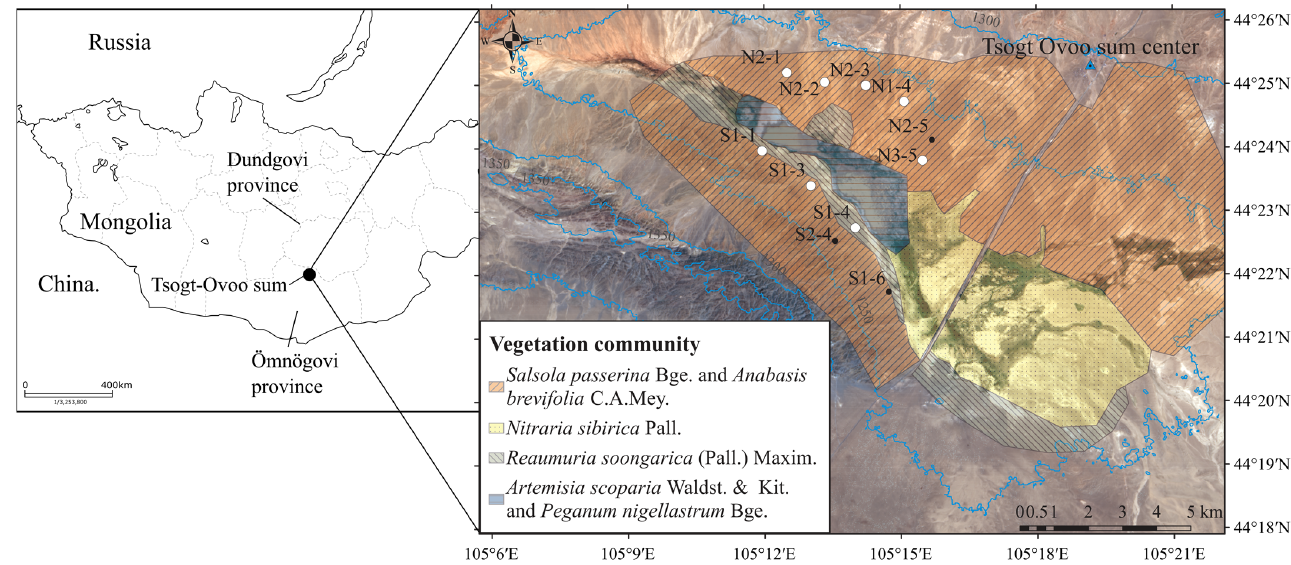
Figure 1. Field survey sites in Tsogt-Ovoo sum. In the right figure, white circles indicate the sites used for both analyses and black circles indicate the sites used only for comparison analysis between groups (as described Section 2.7). Base map of the right figure is a pansharpened image of Landsat 8 acquired on 15 August 2015.